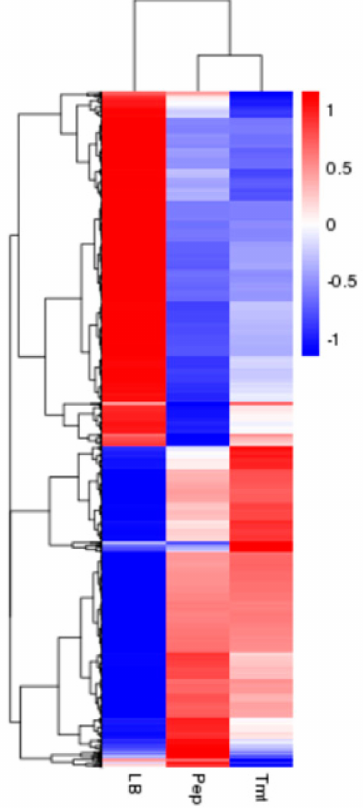
Figure 1. Cluster analysis of di ff erentially expressed genes. the expression pattern in Pep and Tmt are similar compared to that in LB